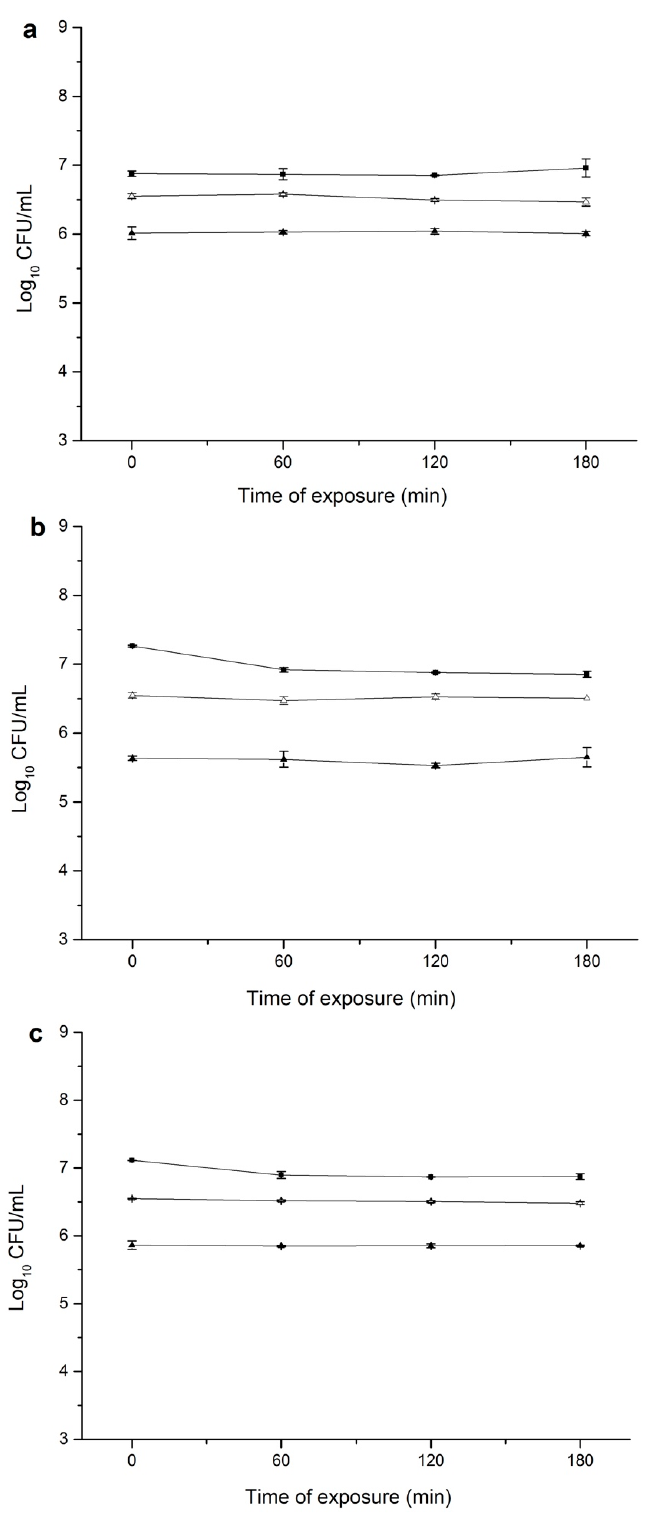
Figure 2. Survival of non ‐ habituated and CEO ‐ habituated S. aureus in LB broth at 45 °C ( a ); with 10 g/100 mL NaCl ( b ); or acidified with lactic acid to pH 4.5 ( c ). ( ■ ) non ‐ habituated cells; ( △ ) cells pre ‐ habituated with 1/4 MIC (125 μ L/L) of CEO; ( ▲ ) cells pre ‐ habituated with 1/2 MIC (250 μ L/L) of CEO. CEO, cinnamon essential oil; MIC, minimum inhibitory concentration. Vertical bars represent standard deviation. Data point symbols without visible error bars signify the standard deviation smaller than the symbol size.